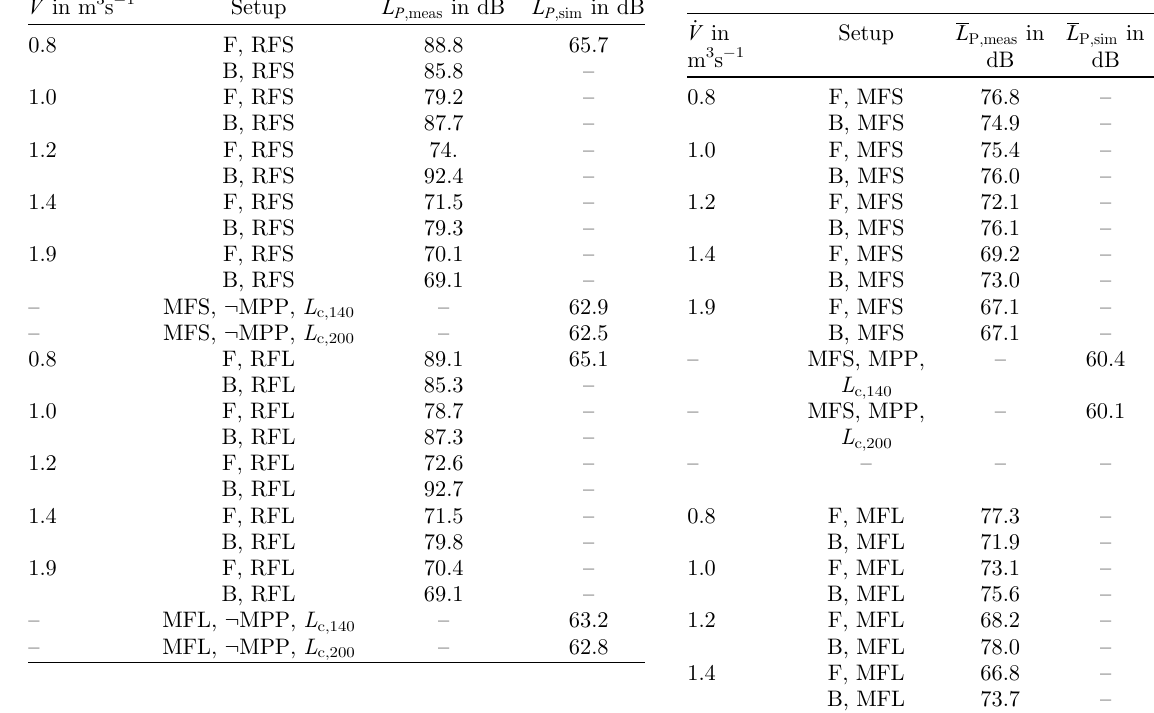
Table 2. Measured ( L P ; meas ) and simulated ( L P ; sim ) overall sound pressure level at different operating points of the fan in MFS